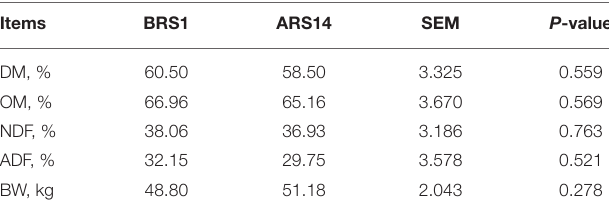
TABLE 1 | Changes in apparent digestibility before and after